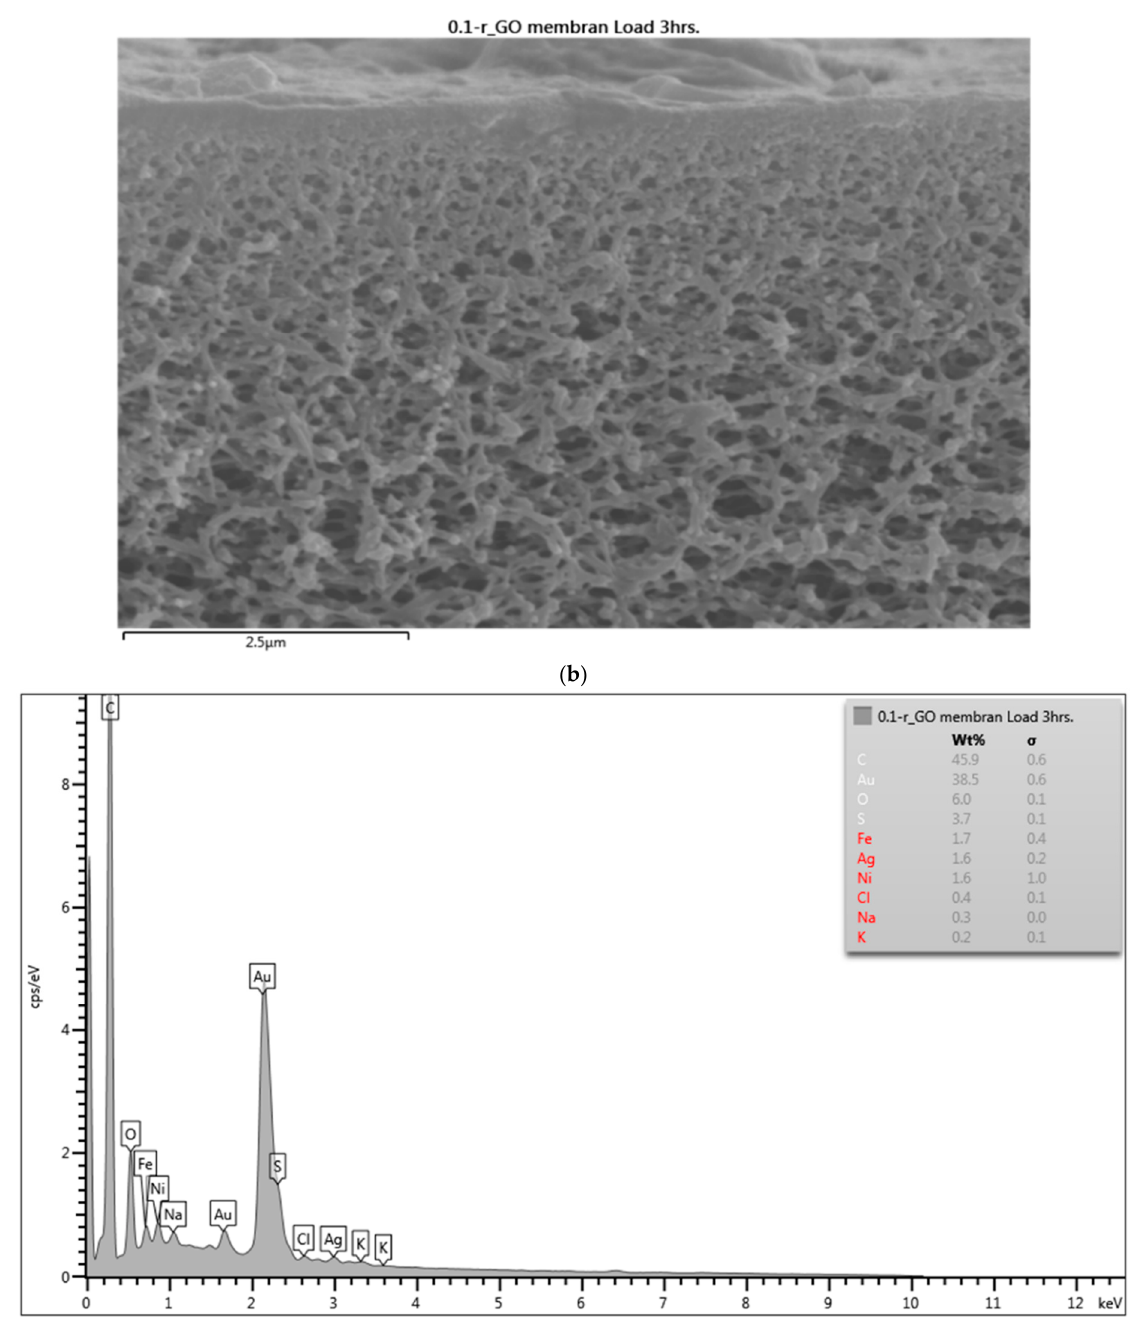
Figure 10. ( a ) Energy dispersive X ‐ ray (EDX) analysis of reduced graphene oxide nanomaterial. ( b ) EDX analysis of the cross ‐ section view of the sample C membrane after iron water filtration. ( c ) EDX analysis of the sample C membrane.